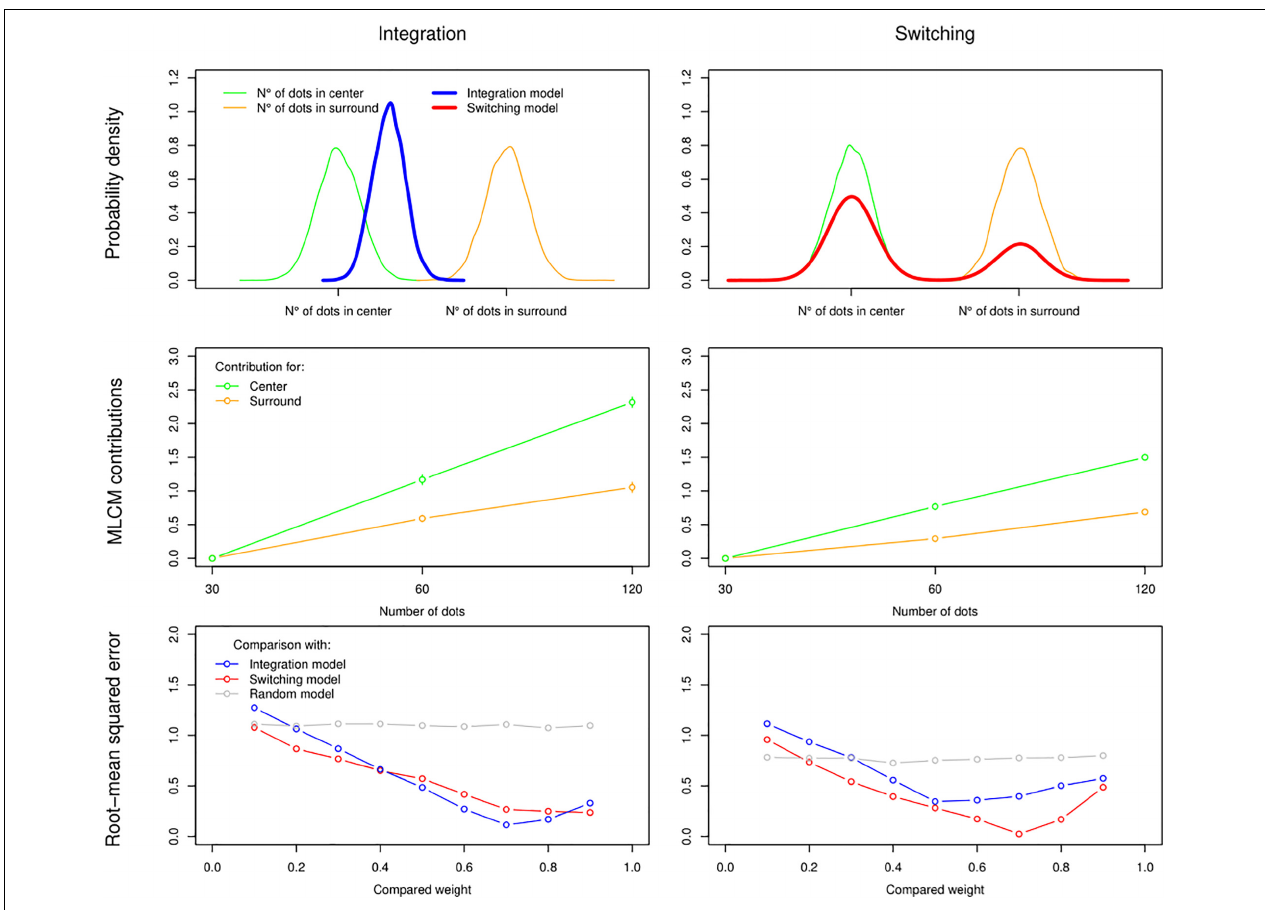
FIGURE 2 | Simulating observers using an Integration rule (left column) or a Switching rule (right column) to estimate perceived numerosity in the centre and surround. Top panel: Probability density functions over 1,000 simulations of the same single combination. In this example weights of 0.7 for centre and 0.3 for surround are applied. Density for the perceived number of dots in centre and surround are represented in green and orange, respectively, and the resulting representations under Integration and Switching rules are in blue and red, respectively. Second panel: results of the MLCM analysis (additive model) applied to simulated responses of observers using Integration and Switching rules (in both cases, the simulated trials were the sum of all trials done by 9 of our human participants to make it comparable to empirical results). Bottom panel: comparison of two rules using RMSE between the simulated data (from the mid-panel) and other simulations with varying weight values and combination rules (Integration, Switching, and Random choice for each trial as a